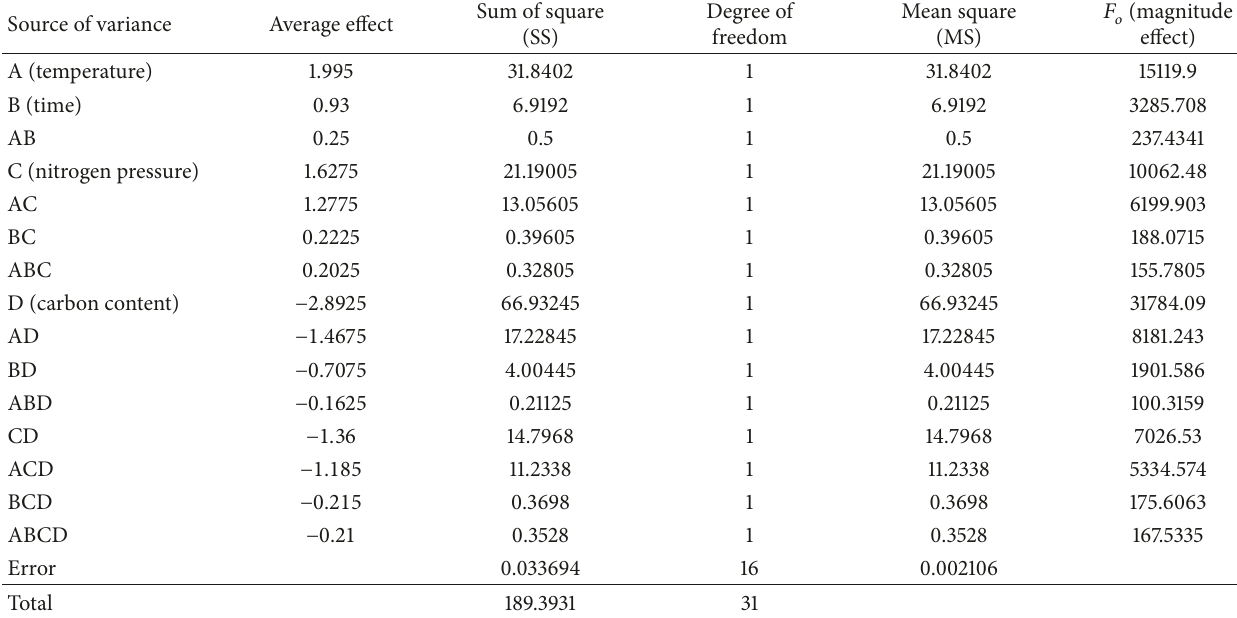
Table 3: Analysis of variances (average effect, sum of square, degree of freedom, mean square, and magnitude effect). Source of